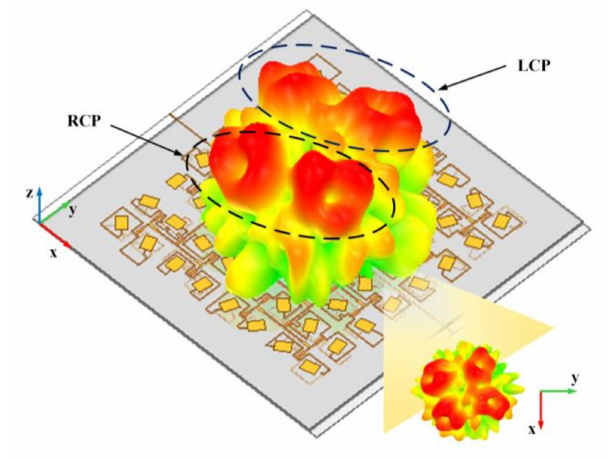
Figure 8. Simulated 3-D radiation pattern at 10 GHz for the quad-vortex-beam in Case I with different OAM modes ( l (A , L) = l (B , L) = − 1, l (A , R) = l (B , R) = 1) at predicted deflection angles of ( θ , φ ) = (30 ◦ , 72 ◦ ), (30 ◦ , 150 ◦ ), (30 ◦ , 252 ◦ ), and (30 ◦ , 330 ◦